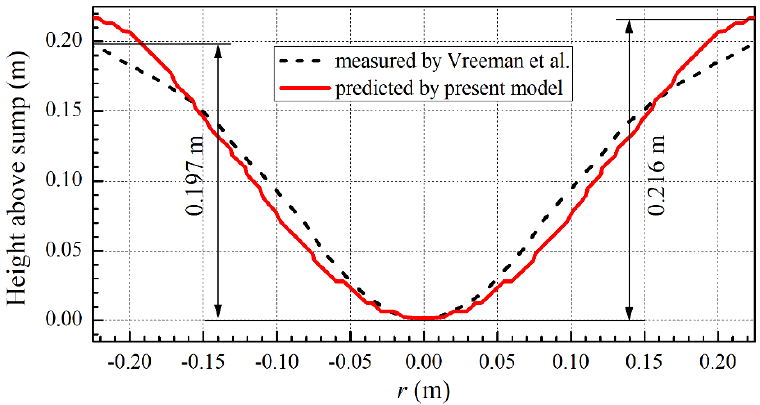
Figure 3. Comparison of the sump profiles ( f s = 0) predicted by present model and measured by Vreeman et al. [21] in the grain-refined billet (case 1).